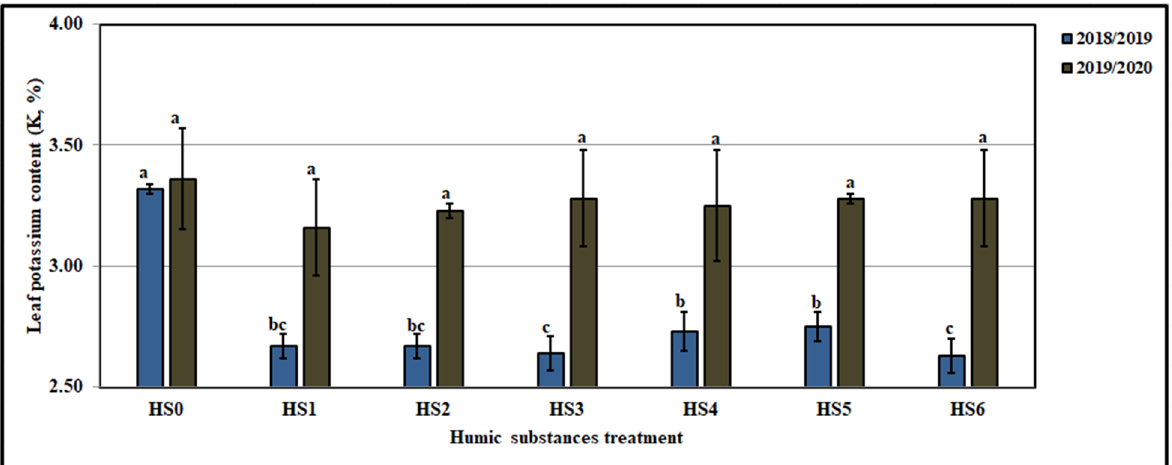
Figure 20. Influence of humic substances treatments on leaf phosphorus contents (P, %) of some wheat varieties grown in clay loam soil in 2018/2019 and 2019/2020 seasons. Bars in the same years with a different letter indicate significant differences between treatments at p ≤ 0.01. HS 1, HS 2 , HS 3 represent HS applied as foliar spray at 1.0, 2.0, 4.0 g L − 1 , respectively, HS 4 , HS 5 , HS 6 represent HS applied as soil application at 5.04, 7.56, 10.08 kg ha − 1 .